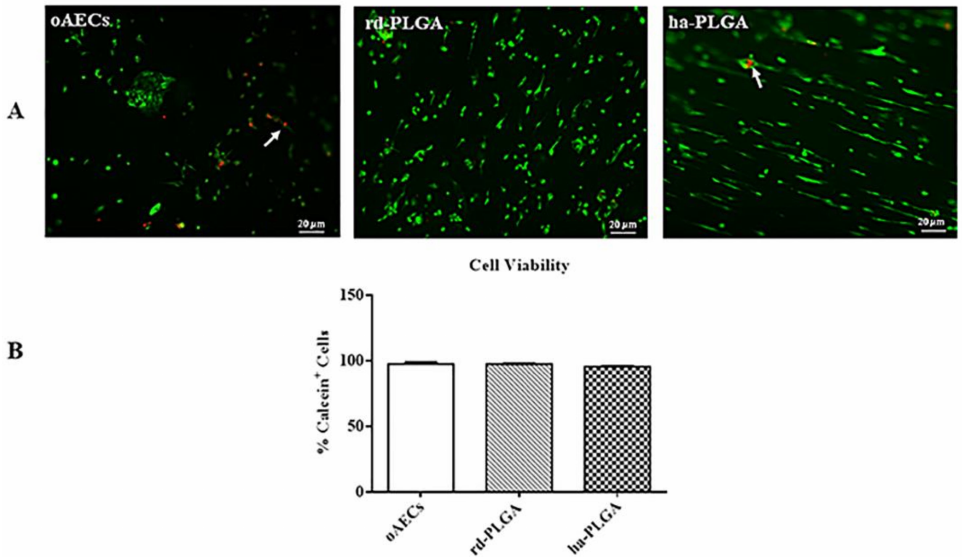
Figure 3. Amniotic Epithelial Stem Cell (AEC) viability on PLGA fleeces. ( A ) Representative images assessing oAEC survival with Calcein AM / propidium iodide (PI) stains (green and red fluorescence, respectively). White arrows indicate positive cells to PI. Scale bars = 20 µ m ( B ) Histogram showing oAEC viability of standardly cultivated cells on a Petri dish (oAECs) and on rd-PLGA or ha-PLGA fleeces after 48 h culture. No statistical di ff erence was evident among the three groups ( p > 0.05); (n = 3 for each type of fleece / time point, sca ff old size: 15 mm × 7